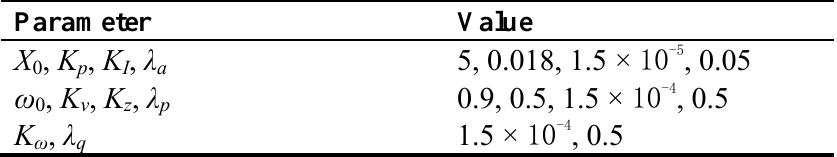
Table 1. Non-dimensional values of the control parameters.